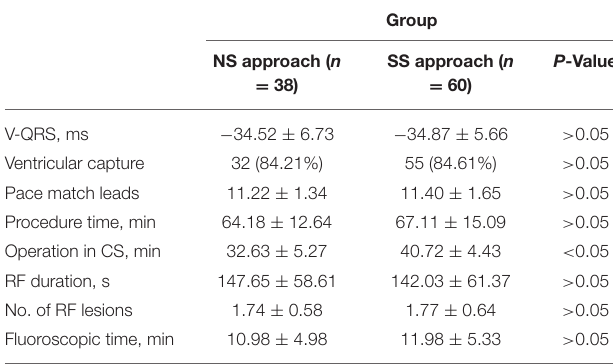
TABLE 3 | Comparison of electrophysiological study and radiofrequency catheter ablation of successful ablated VAs between two manipulation methods.